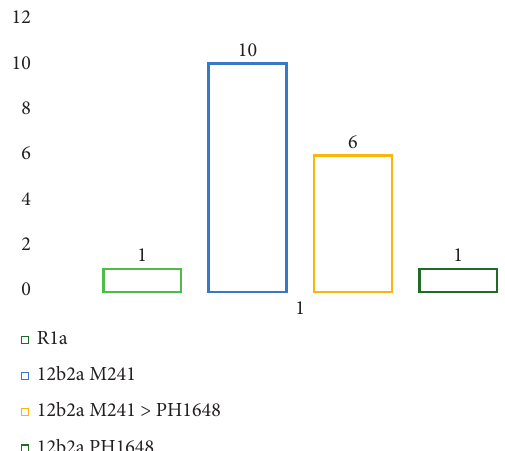
Figure 3: Graphical representation of relative abundance of different haplogroups observed in AMEL-Y-null Pakistani males.